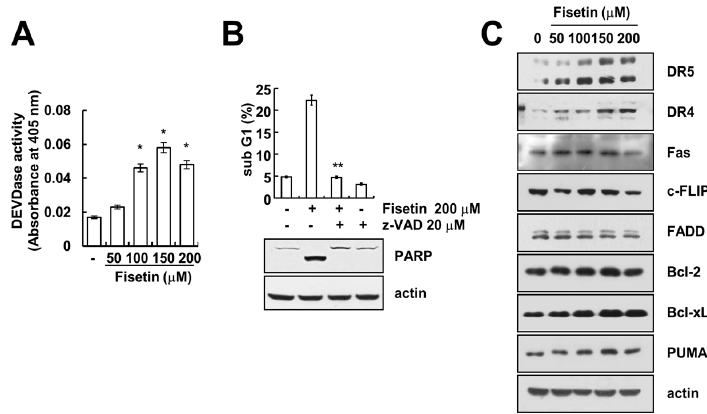
Figure 2. Fisetin induced apoptosis in a caspase-dependent manner. ( A ) Caki cells were treated with the indicated concentrations of fisetin for 24 h. Caspase activities were determined with colorimetric assays using caspase-3 (DEVDase) assay kits; ( B ) Caki cells were treated with 200 μ M fisetin in the presence or absence of 20 μ M z-VAD-fmk (z-VAD). The sub-G1 fraction was measured by flow cytometry. The protein expression levels of PARP and actin were determined by Western blotting. The level of actin was used as a loading control; ( C ) Caki cells were treated with the indicated concentrations of fisetin for 24 h. The protein expression levels of DR5, DR4, Fas, c-FLIP, FADD, Bcl-2, Bcl-xL, PUMA and actin were determined by western blotting. The level of actin was used as a loading control; the values in ( A , B ) represent the mean ± SD from three independent samples. * p < 0.01 compared with the control. ** p < 0.01 compared with the fisetin treatment.